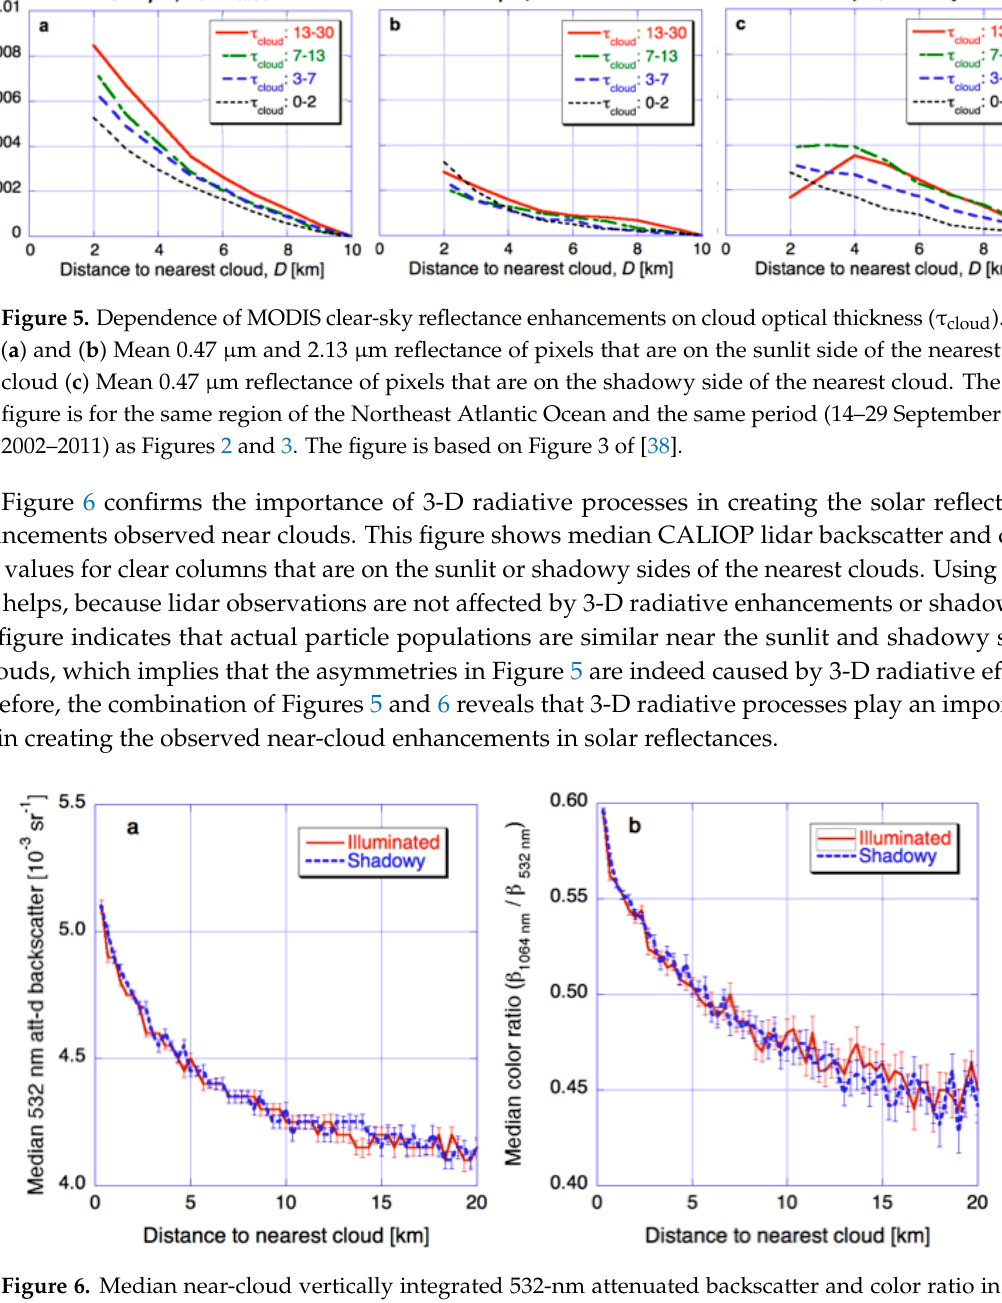
Figure 6. Median near-cloud vertically integrated 532-nm attenuated backscatter and color ratio in daytime CALIOP observations over all oceans between 30° and 60° latitudes in both hemispheres. The solid and dashed lines are for profiles that are on the sunlit and shadowy sides of the closest cloud, respectively. The figure is based on Figure 4 of [27].